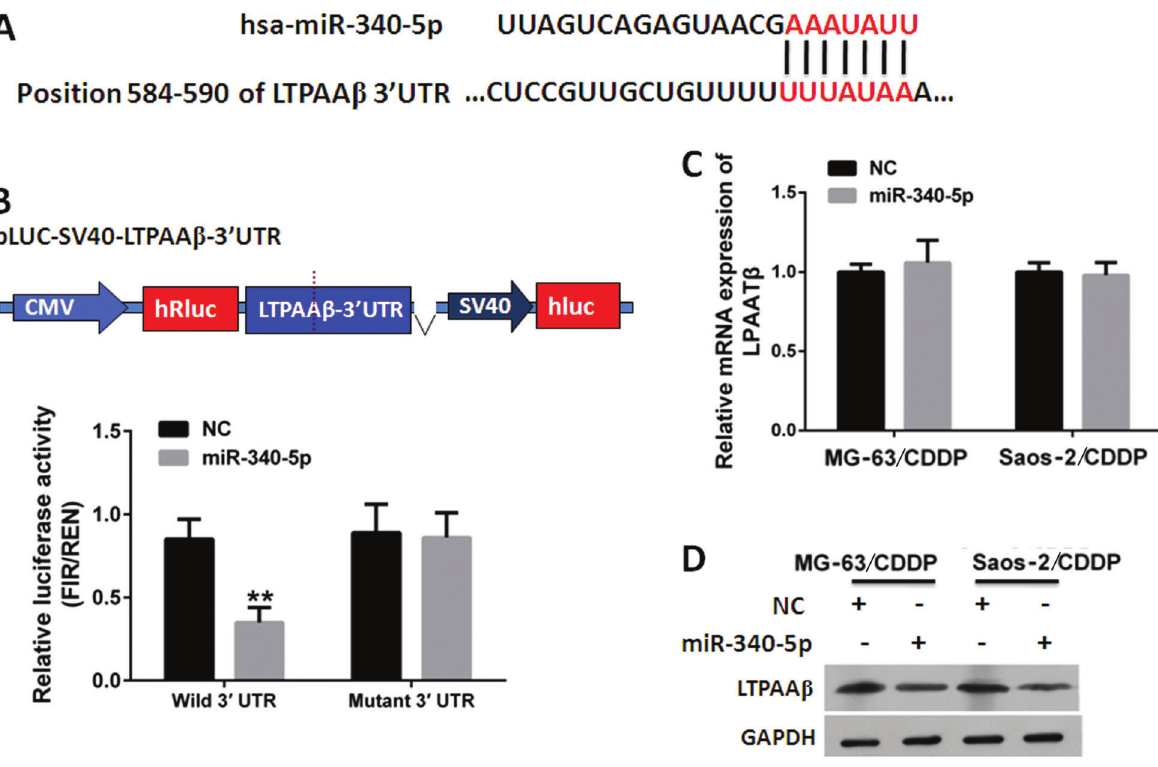
Figure 3. A , Schematic diagram of interaction between miR-340-5p and LPAAT b . B , Dual luciferase assay of cells co-transfected with luciferase reporter constructs and miR-340-5p or normal control (NC). C , miR-340-5p did not affect mRNA expression of LPAAT b in MG-63/CDDP and Saos-2/CDDP cells. Data are reported as means ± SD. **P o 0.01 (Student ’ s t -test). D , miR-340-5p decreased protein expression of LPAAT b in MG-63/CDDP and Saos-2/CDDP